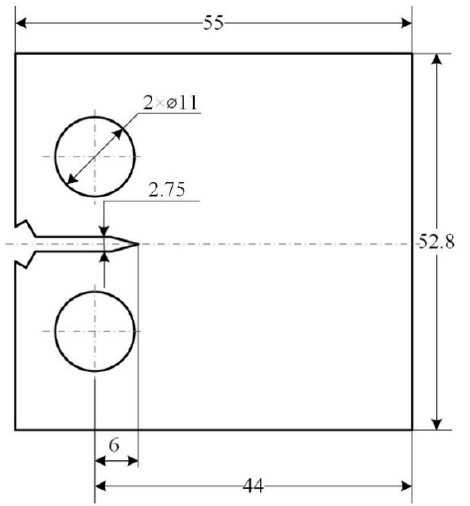
Figure 2. Schematic diagram of CT specimen for fatigue-crack propagation experiment.